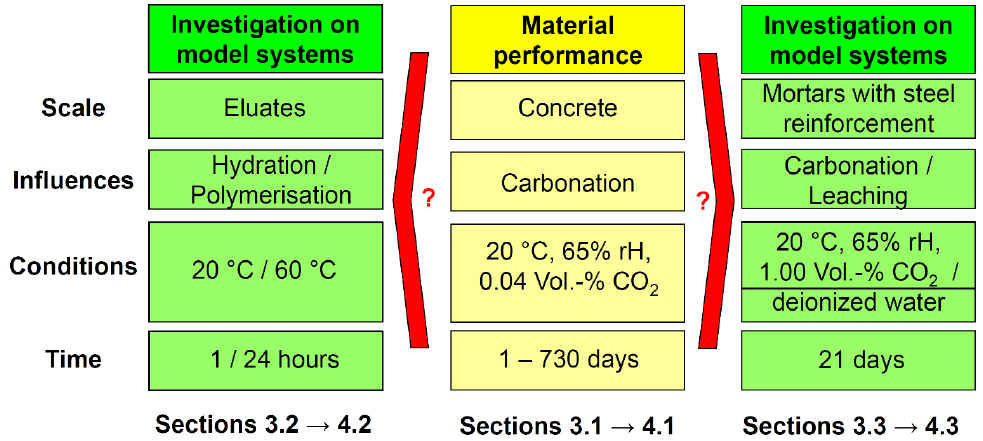
Figure 16. Schematic visualization of the test approaches.